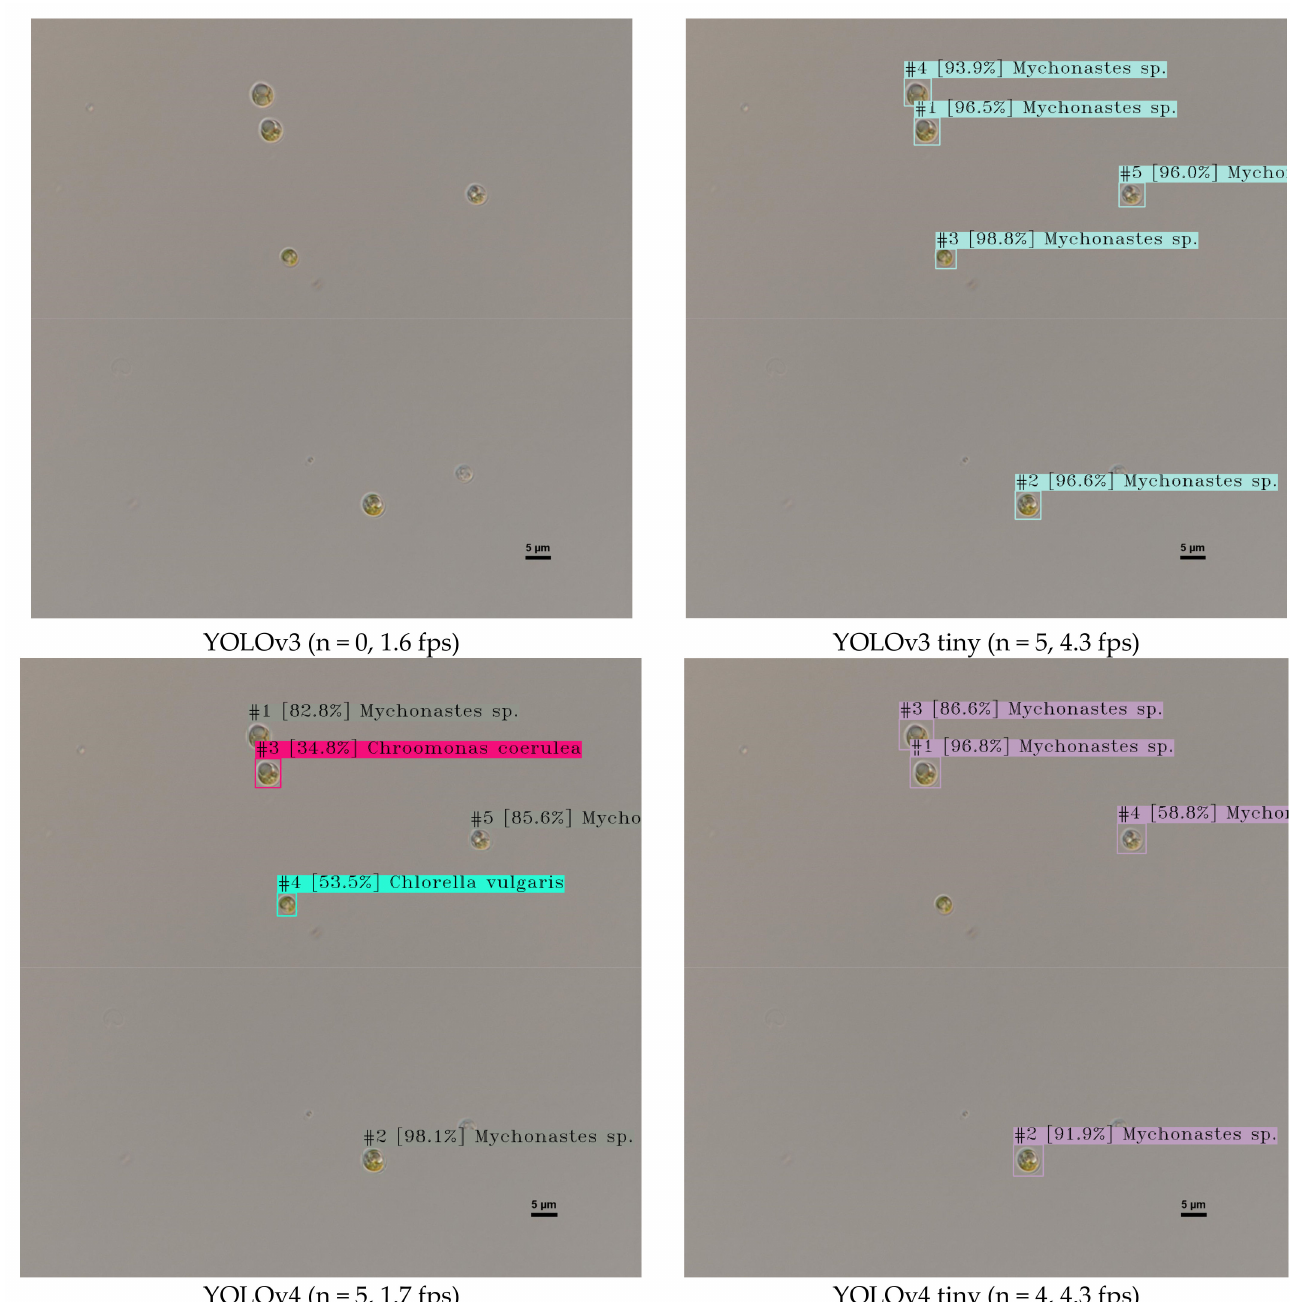
Figure 6. Comparison of the algal detection model performance with sparsely distributed relatively small-size algal cell